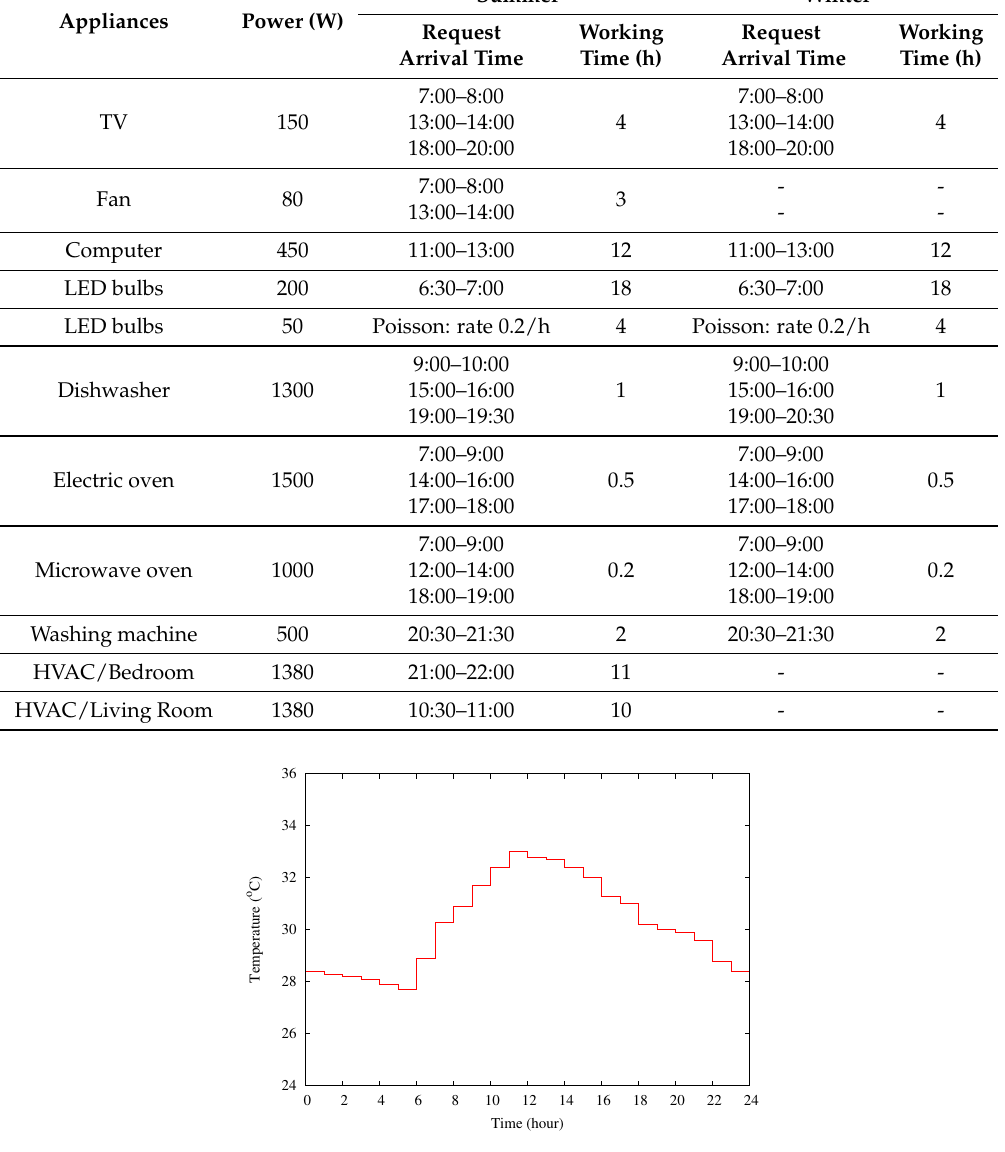
Figure 6. Outdoor temperature